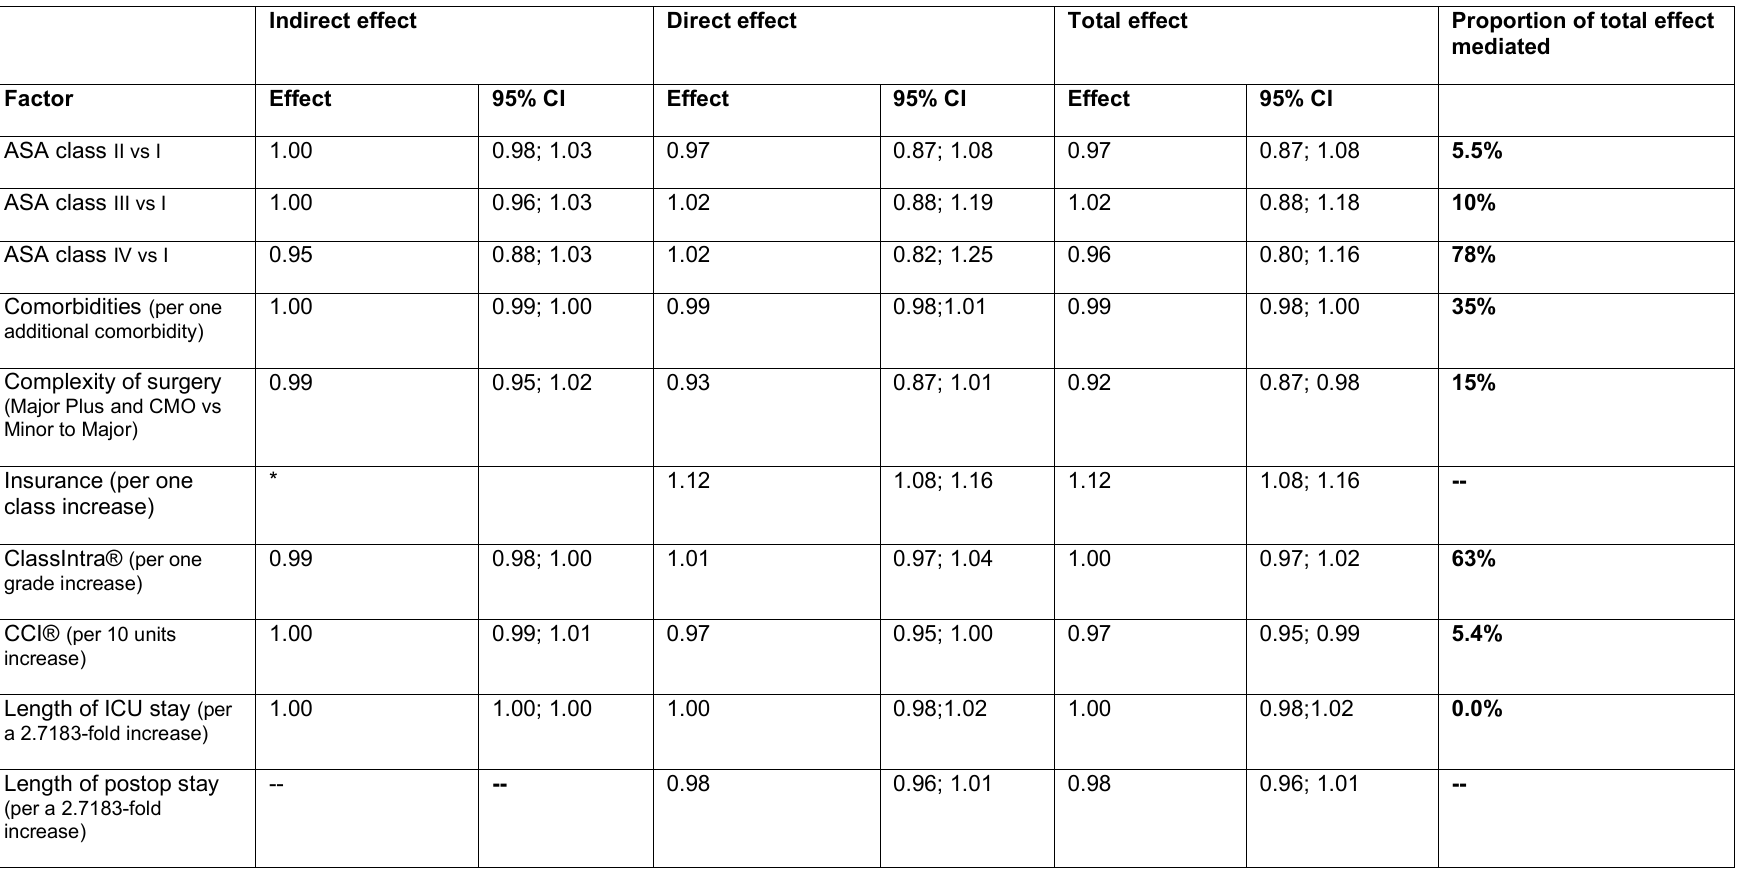
Table 7: Log-reimbursement model excluding recurrent patients Indirect, direct and total effects on log-reimbursement. Coefficients are exponentiated to report the ratio in geometric means associated with a one-unit increase in the corresponding predictor variable. From these ratios, the percentage increase in geometric mean can be derived using the formula 100*(effect-1), e.g. 0.96 corresponds to a 4% decrease in geometric mean as compared to ASA I patients). R-squared